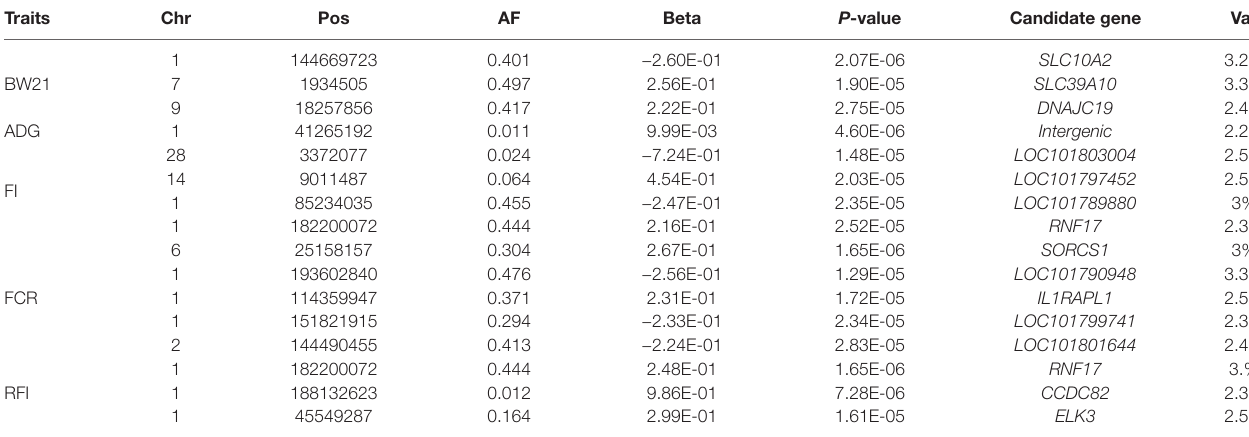
TABLE 3 | Significant loci determined from the association analysis.